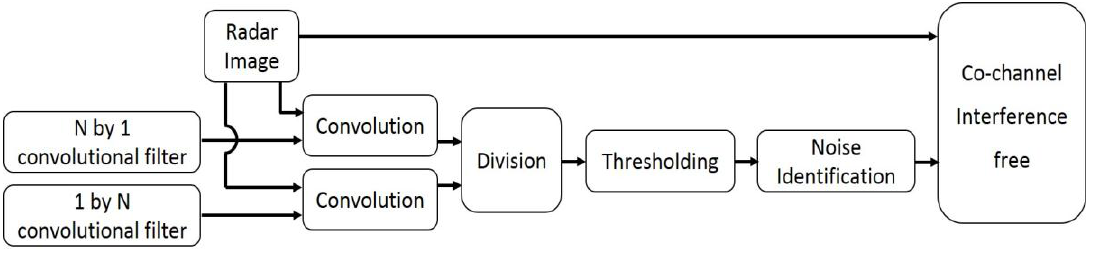
Figure 4. Data processing of clearing co-channel interference.